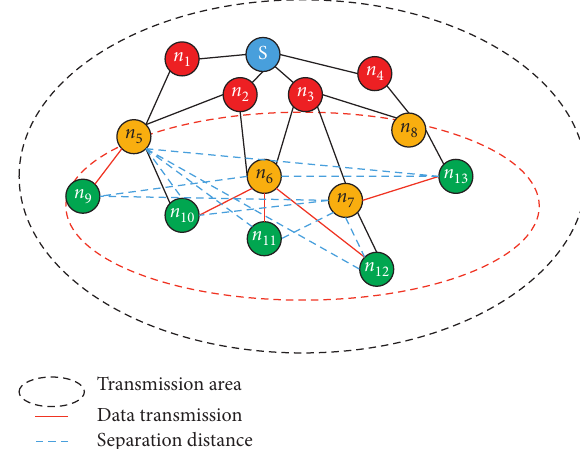
Figure 9: Broadcast link scheduling in community 3.